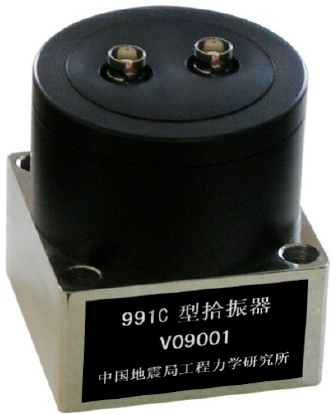
Figure 14. Model 991C accelerometer . Table 4. The main performance indicators of the Accelerometer.